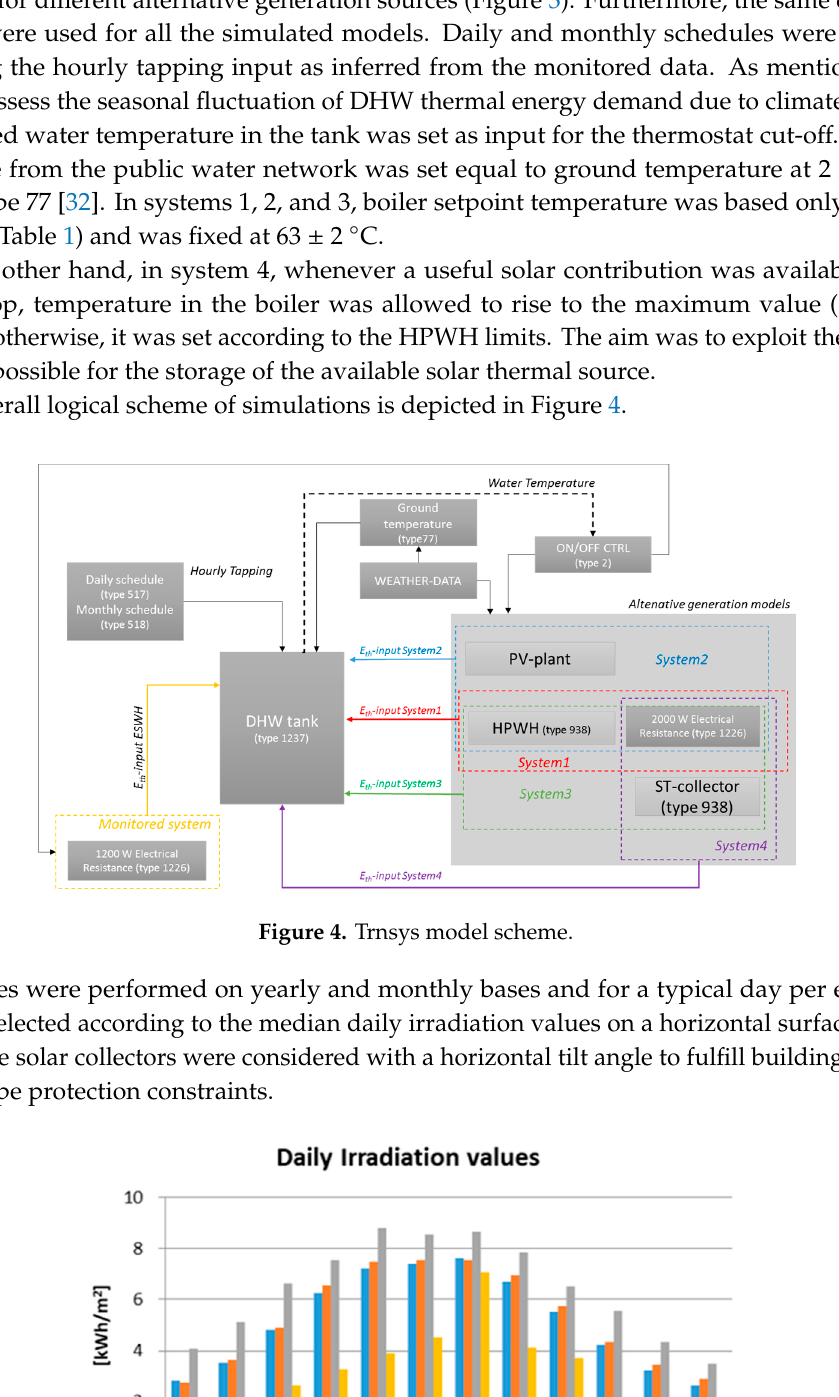
Figure 5. Analysis of specific horizontal irradiation values on Lampedusa Island, Italy (35°30 ′ 56 ″ north (N)). 2.4. Empirical Definition of Domestic Hot Water Tapping Profiles Figure 6 shows the average daily energy consumption per month calculated from monitored data for two users equipped with a conventional ESWH system. It is worth noting that, even if different magnitudes of values were observed, monthly data regarding the two detected users had similar decreasing trends from February until July/August. Furthermore, data for the month of September ere probably affected by the presence of a larger number of persons in the residential units. Figure 6. Monitored data.